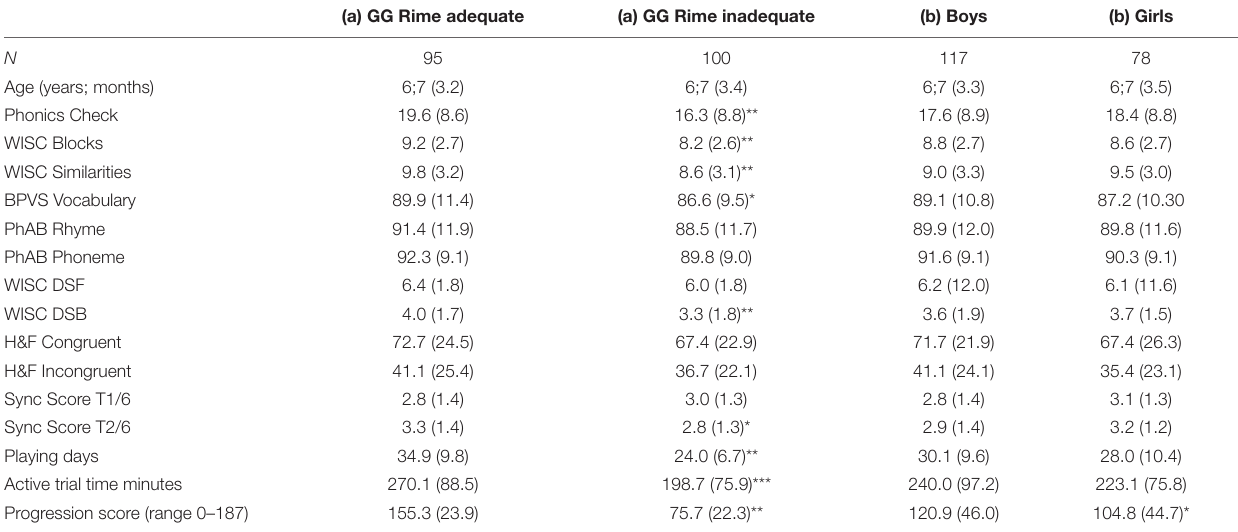
TABLE 5 | Means and standard deviations in parentheses for group characteristics prior to the intervention for (a) GG Rime players who were adequate versus inadequate responders as measured by their progression through the game, and (b) boys and